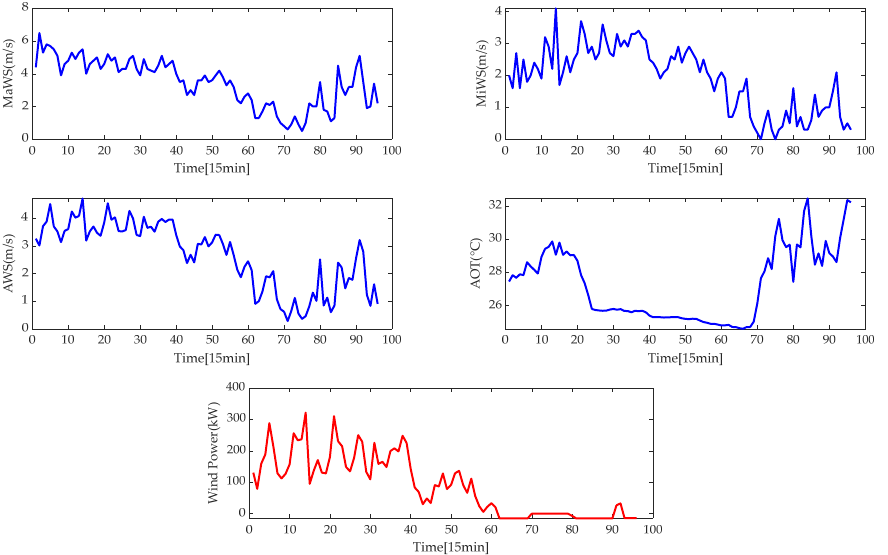
Figure 3. Wind power and impact factor data curves in one day. (2)The PV dataset was obtained from a PV farm in the Australian Solar Energy Cen ‐ tre in 2016. For the PV power forecasting case, the training data are 19,968 data from 0:00